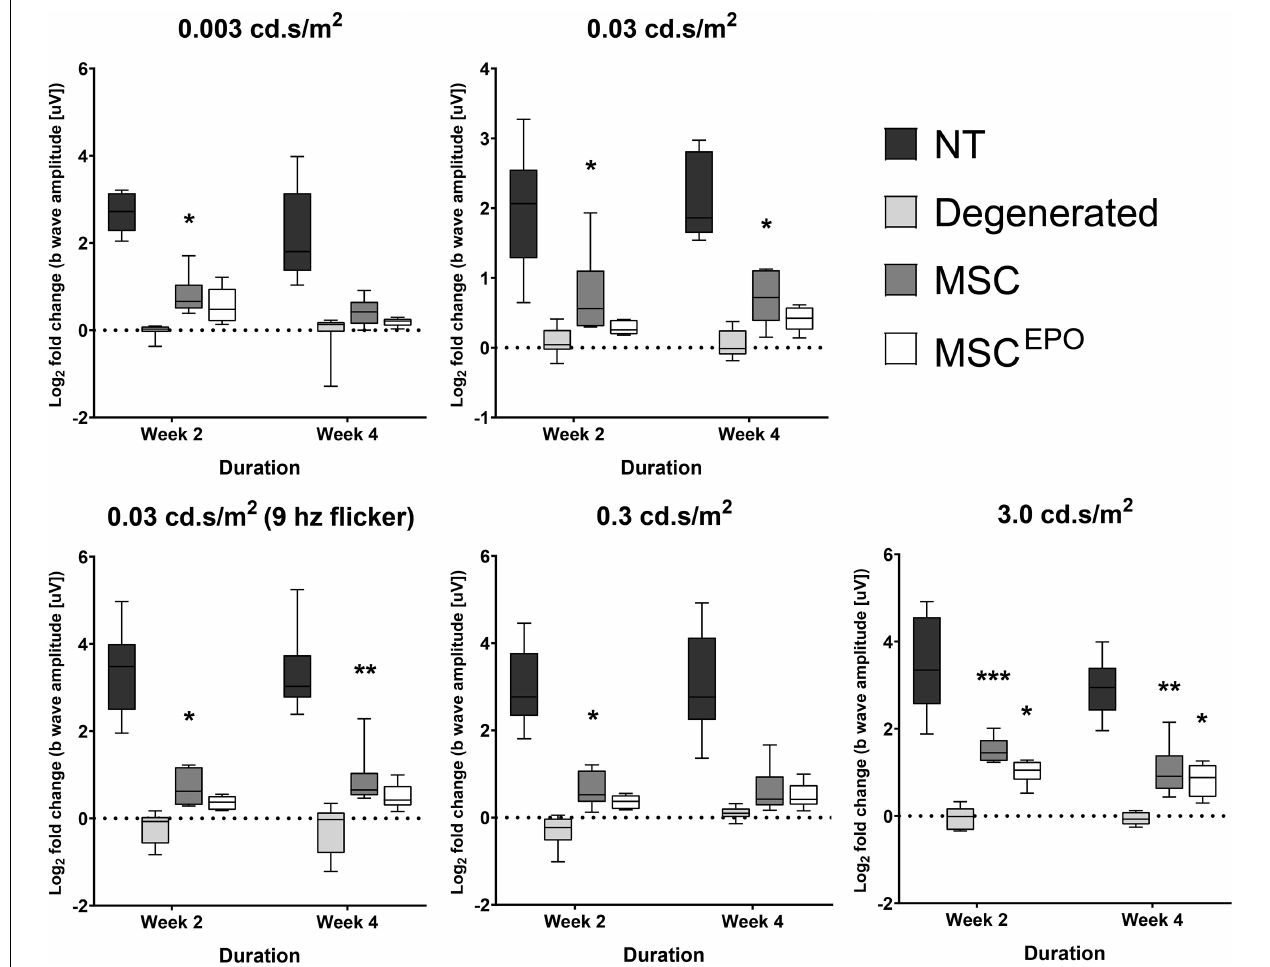
FIGURE 3 | Electroretinographic readings of stem cell-transplanted retinal degeneration models in the study. An ERG test was performed on week 2 and week 4 to assess the effectiveness of MSC and MSC EPO in protecting the retina from sodium iodate-induced damage. Five flash intensities were used (0.003, 0.03, 0.03–9 hz flicker, 0.3, and 3.0 cd.s/m2) for the recording. Rats transplanted with MSCs showed strong ERG responses in week 2 but began to weaken by week 4. Conversely, although the effectiveness of MSC EPO was only detected with the brightest flash intensity, the responses were more consistent throughout the study. The results were presented as mean ± SEM. Two-way ANOVA, followed by Tukey’s multiple comparisons test post-hoc, was used to obtain the P values (* P < 0.05, ** P < 0.01, *** P < 0.001). NT, no-treatment control; Degenerated, NaIO 3 -only/vehicle control; MSC, MSC-transplanted group; MSC EPO , MSC EPO -transplanted